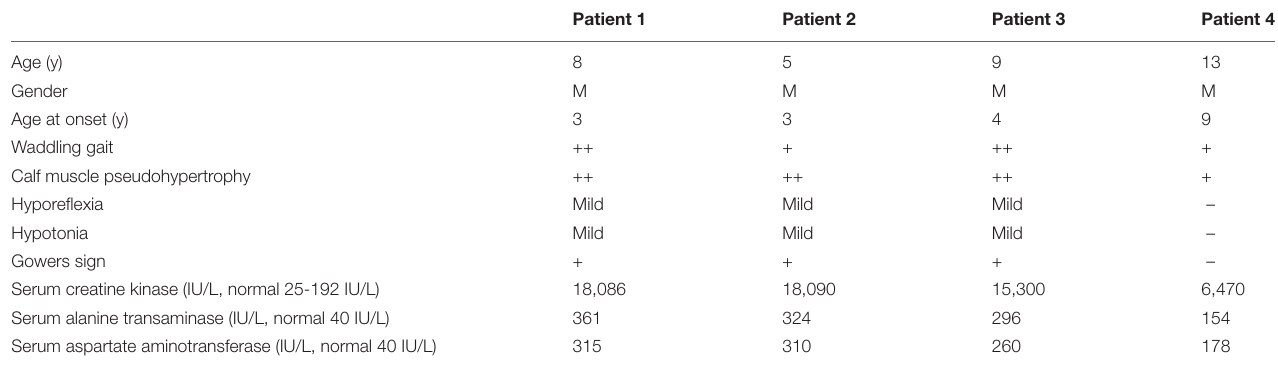
TABLE 1 | Detailed characteristics of identified DMD/BMD